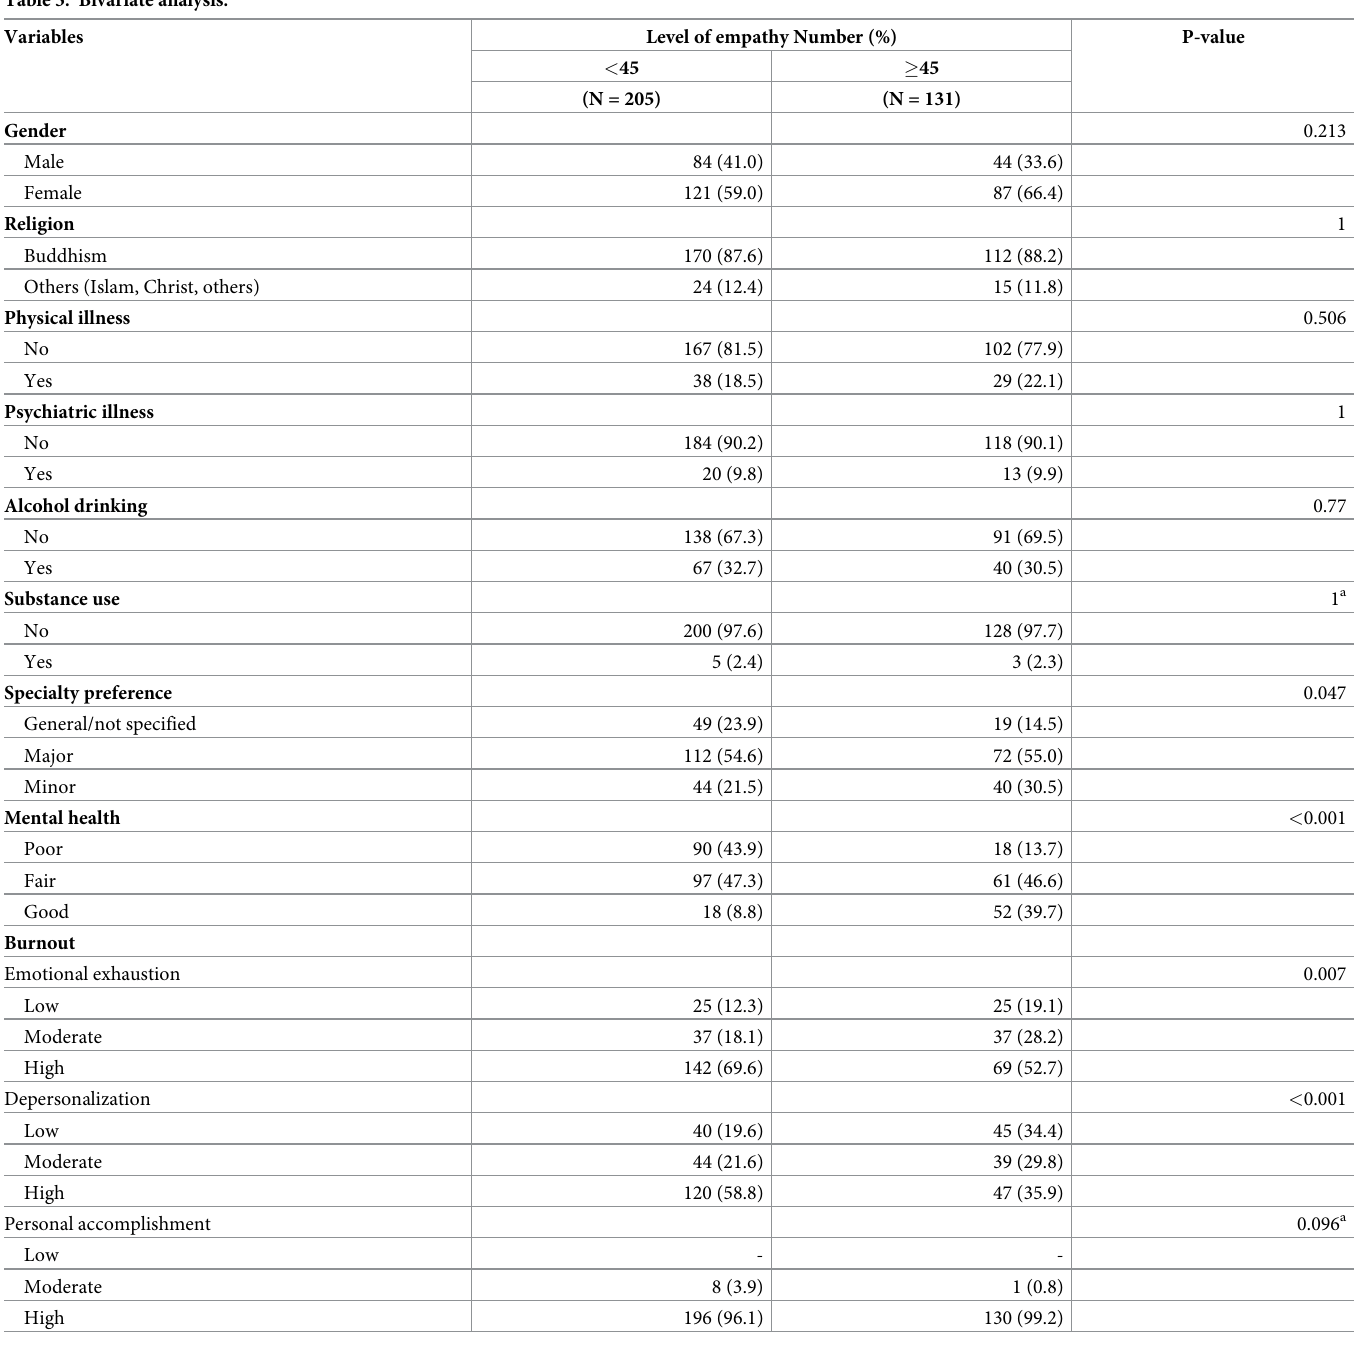
Table 3. Bivariate